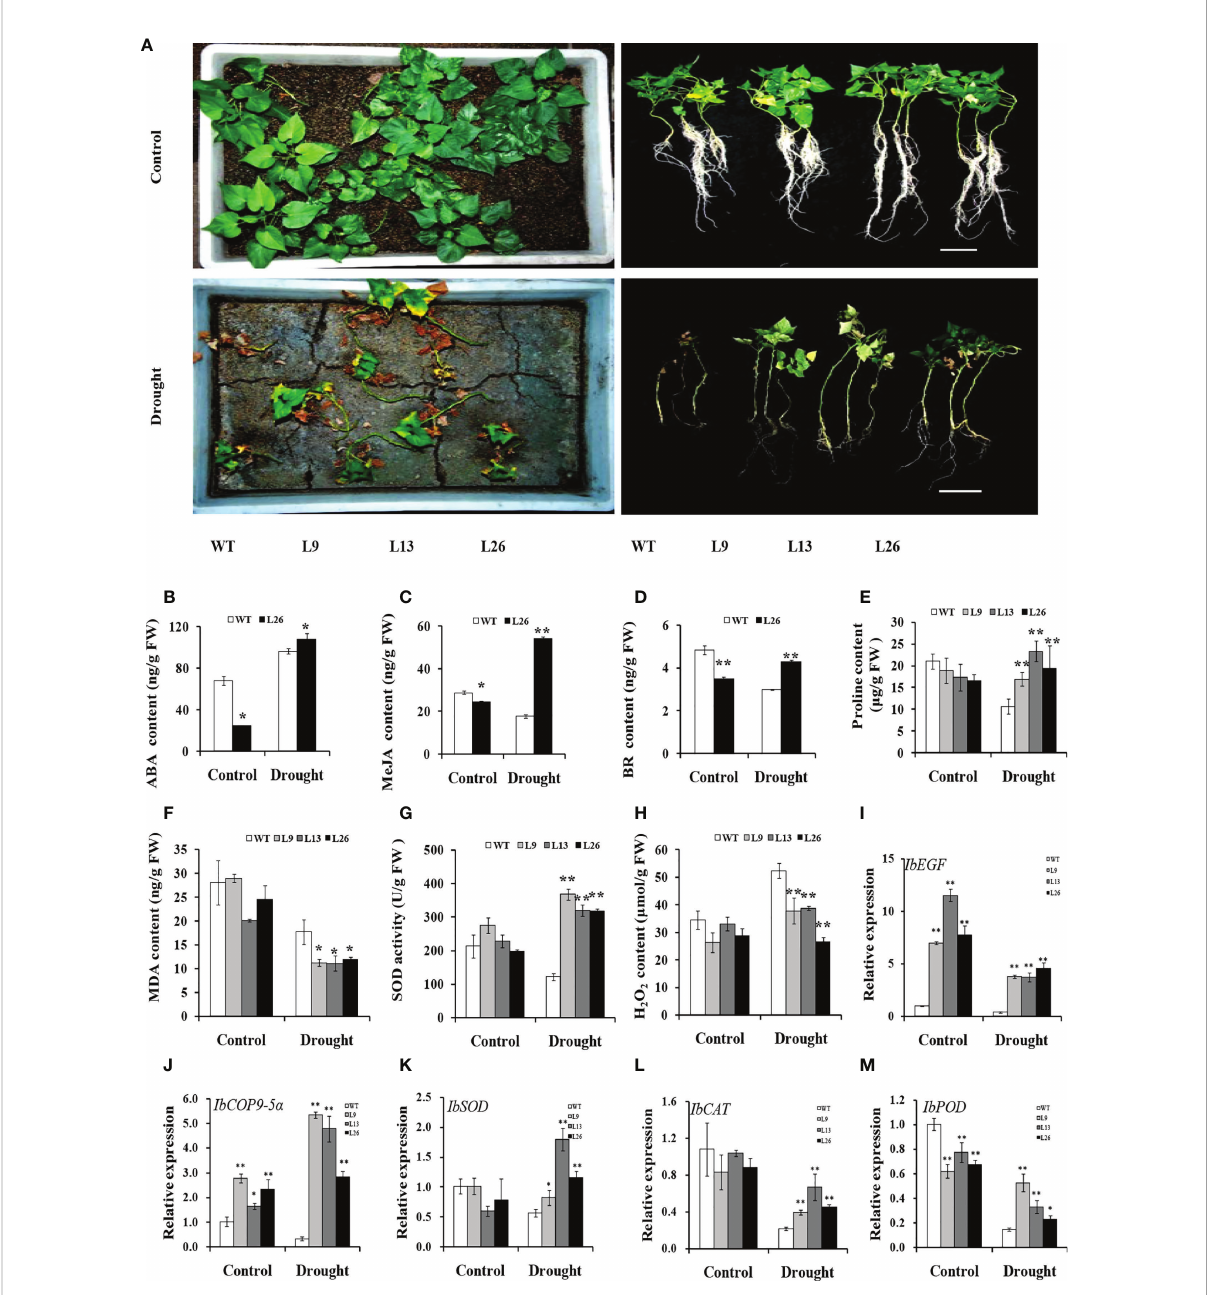
FIGURE 5 Responses oftransgenicsweet potato plants and WT grown intransplanting boxes todrought stress. (A) Phenotypes ofplants irrigated with Hoagland solution for 8 weeks(control) orstressed by an 8-week-longdrought treatment. (B – H) ABA content,MeJA content, BR content,proline content, MDA content, SOD activity,and H 2 O 2 content in the leaves ofplants after4 weeksof treatment, respectively. (I – M) Transcript levels of IbEGF , IbCOP9- 5 a , IbSOD , IbCAT , and IbPOD inthe leaves of plants after4 weeksof treatment, respectively. The transcript levels ofthe genes inWT under normal treatment wereset to 1.* and **indicate signi fi cant differences fromthat ofWTat P <0.05 and P <0.01, respectively, according to Student ’ s t